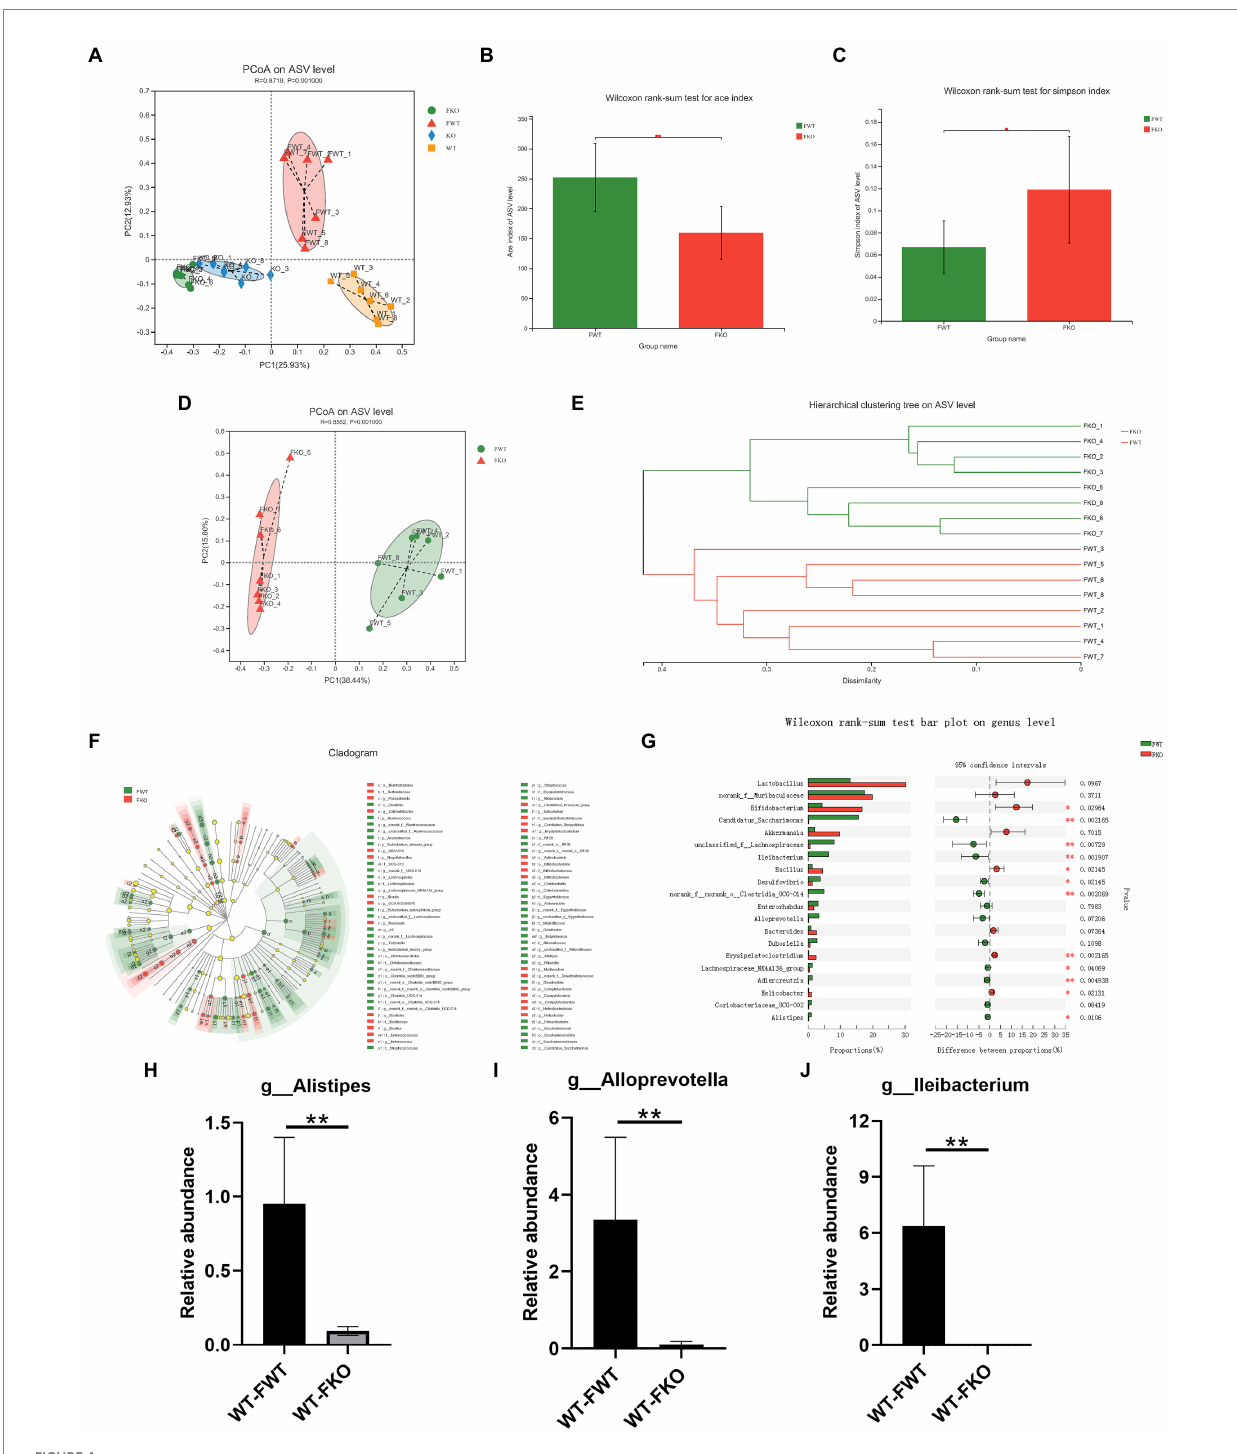
FIGURE 4 FMT alters the gut microbiota in recipient mice. (A) The gut microbiota PCoA analysis of four groups of mice. (B) ACE index and (C) Simpson index of the gut microbiota. (D) PCoA and (E) hierarchical clustering of 16S rRNA gene sequences. (F) The LEfSe analysis of the gut microbiota from the phylum level down to the genus level. (G) Composition of the gut microbiota at the genus level. (H–J) The relative abundance of Alistipes , Alloprevotella , and Lleibacterium. ** p < 0.01. WT-FWT, n = 6; WT-FKO, n =